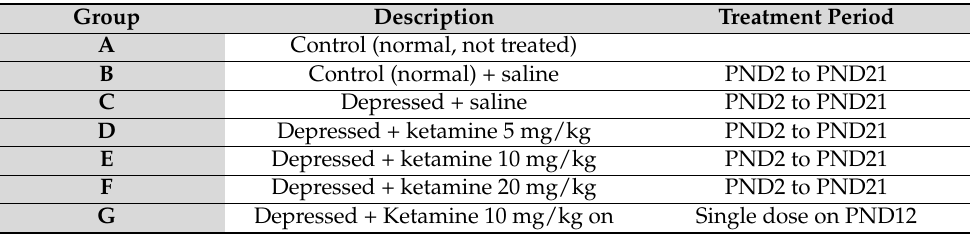
Table 1. Division of the experimental groups. Group Description Treatment Period A Control (normal, not treated) B Control (normal) + saline PND2 to